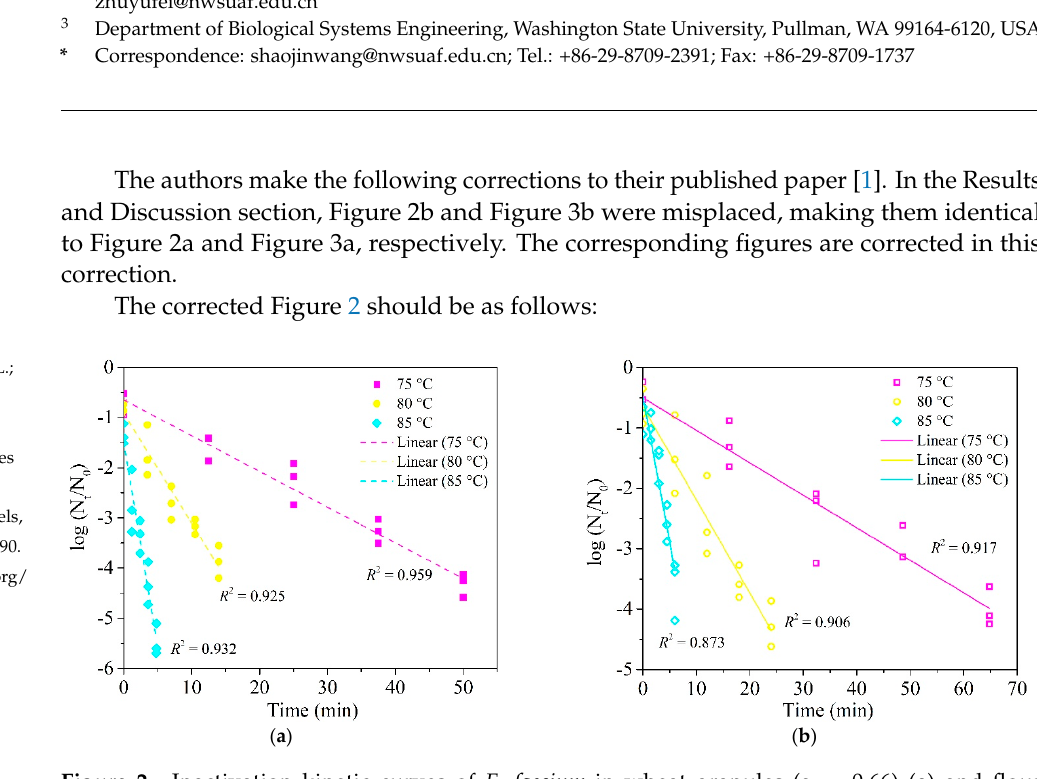
Figure 2. Inactivation kinetic curves of E. faecium in wheat granules (a w = 0.66) ( a ) and flour (a w = 0.65) ( b ) at 75, 80 and 85 °C under a fixed heating rate of 5 °C/min in the HBS. The corrected Figure 3 should be as follows: